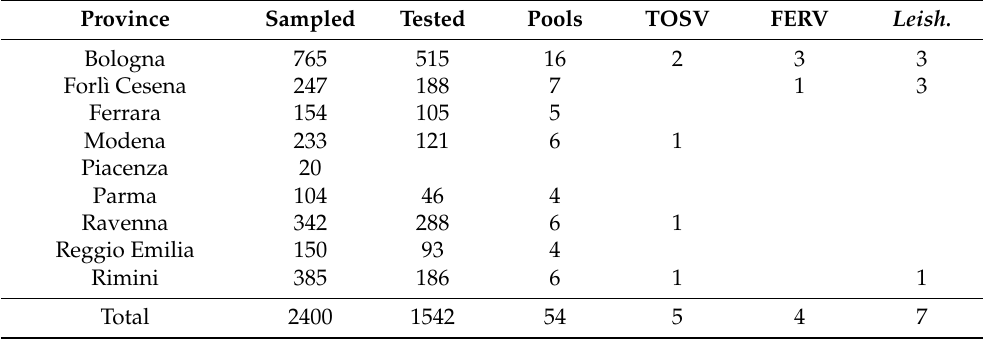
Table 2. Sand flies collected and tested in 2021 by the number of pools tested and the pathogens detected.